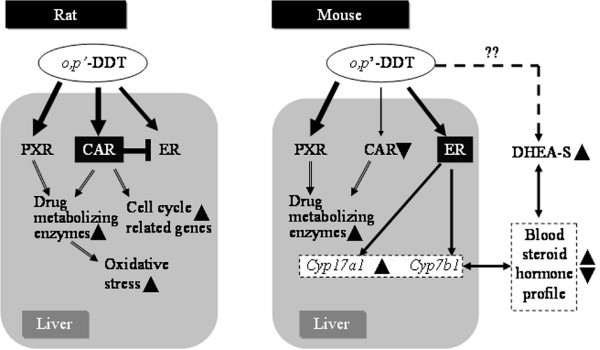
Potential species-specific responses to o, p'-DDT. In the rat liver, o, p'-DDT elicits PXR/CAR-mediated response, with negligible ER-mediated effects despite the established estrogenicity of o, p'-DDT in other target tissues (e.g., uterus). The absence of ER-mediated gene expression may be due, in part, to the inhibitory effects of CAR on ER. In contrast, o, p'-DDT elicits not only PXR/CAR-mediated responses but also ER-mediated effects such as the induction of Cyp17a1 and Cyp7b1 in the mouse liver. Gene expression profiling suggests that o, p'-DDT preferentially activates PXR in the mouse liver. Therefore, the inhibitory effects of CAR on ER-mediated signaling would be reduced in the mouse liver, allowing the activation of ER-mediated gene expression by o, p'-DDT. In addition, only mouse DHEA-S levels were increased, which could affect both endocrine and liver physiology. The induction of Cyp17a1 and Cyp7b1 may be involved in either the metabolism or disposition of DHEA, or the conversion of DHEA into other metabolites including neurosteroids.